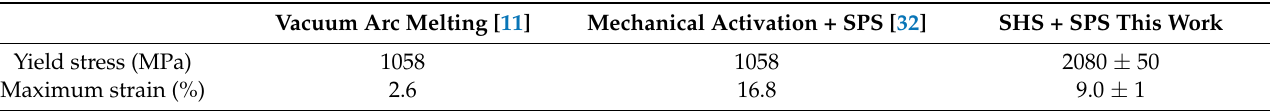
Table 3. Yield stress and maximum strain in compression at room temperature for